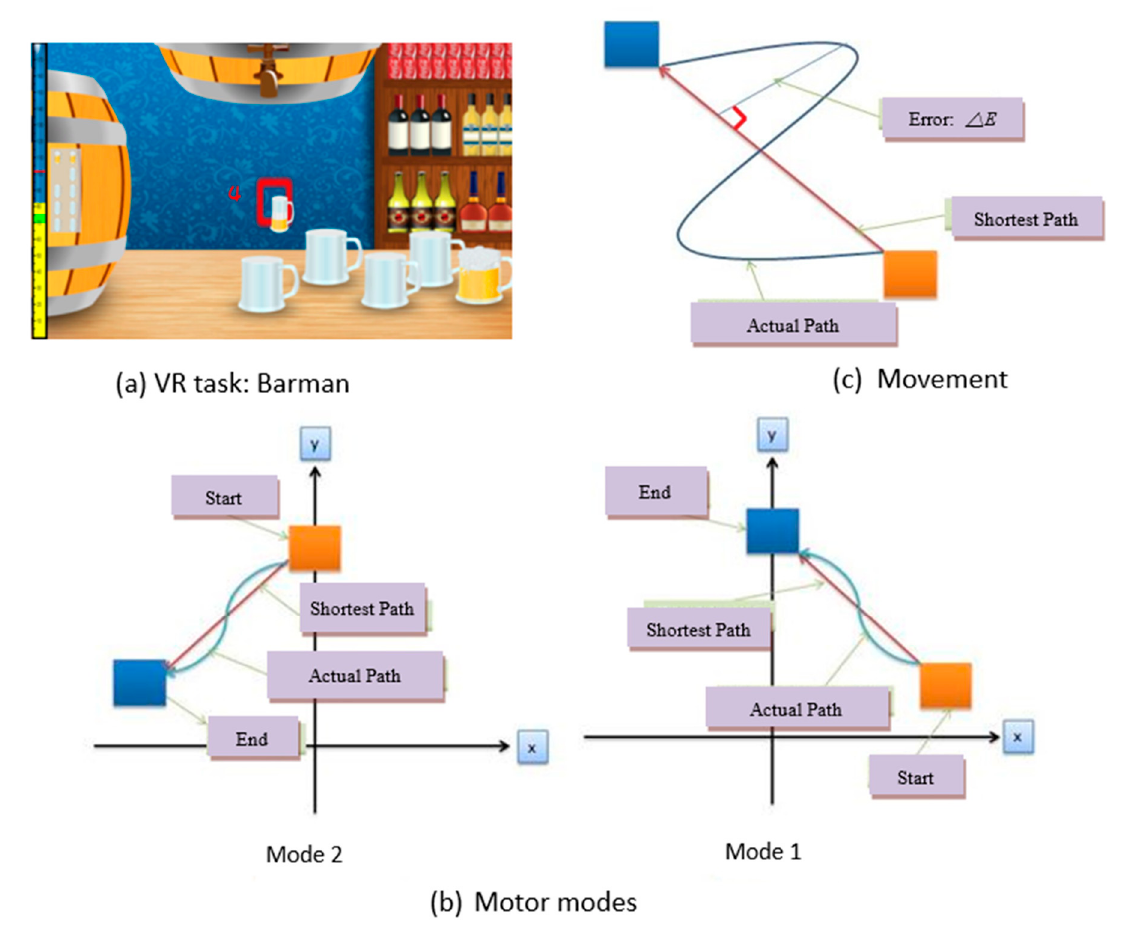
Figure 3. VR task: